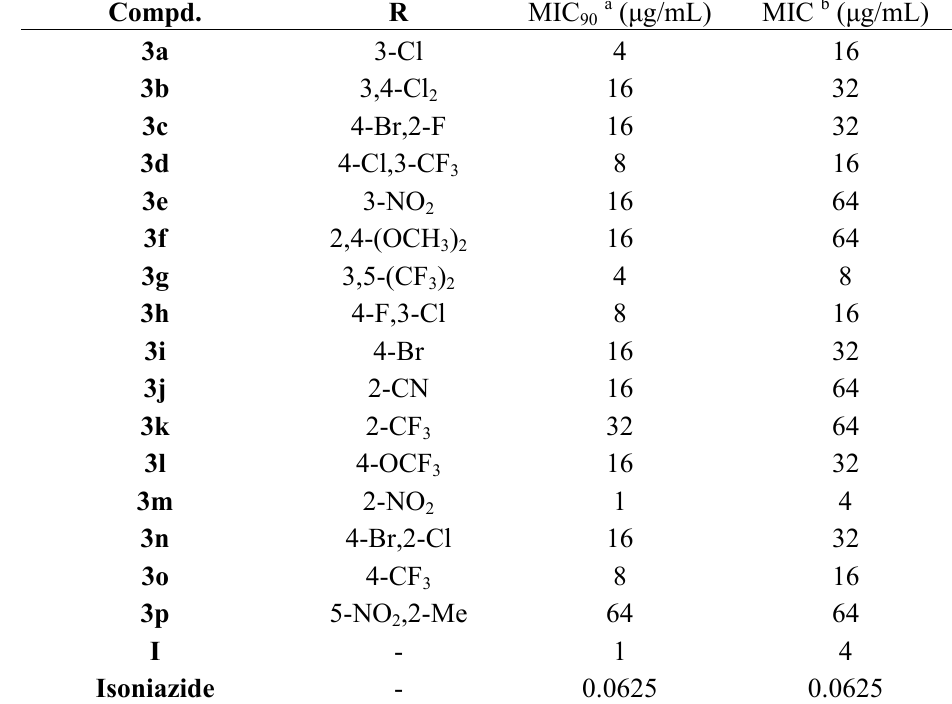
Table 1. The MIC and MIC values of 2-(3-fluoro-4-nitrophenoxy)- N -phenylacetamide 90 derivatives 3a–p against M. tuberculosis H 37